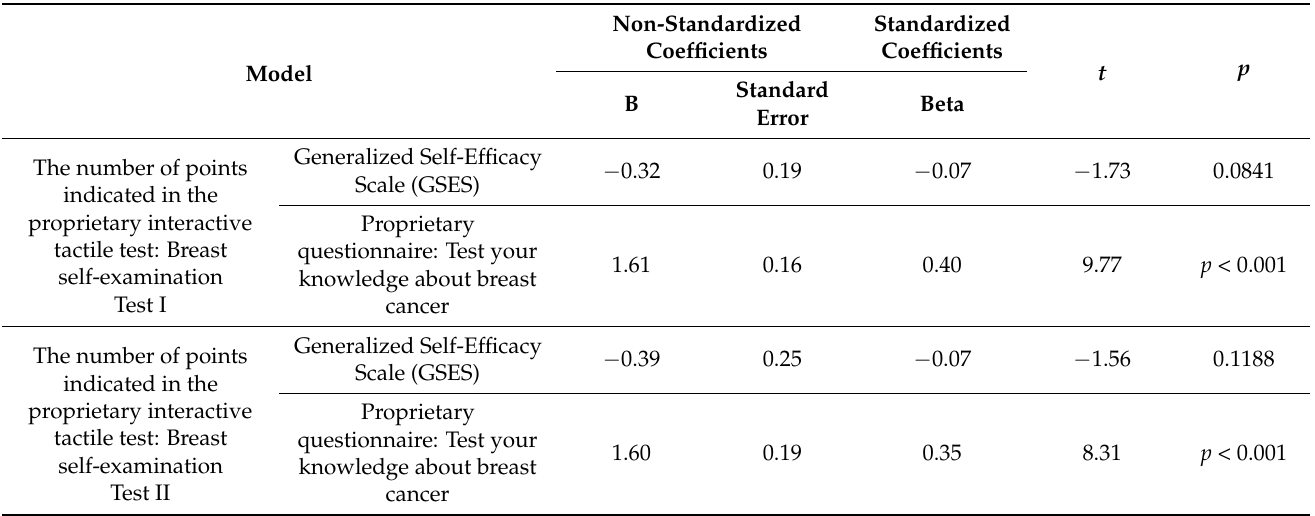
Table 10. Influence of selected factors on the number of points indicated in breast self-examination— multivariate linear regression using the variable input method.